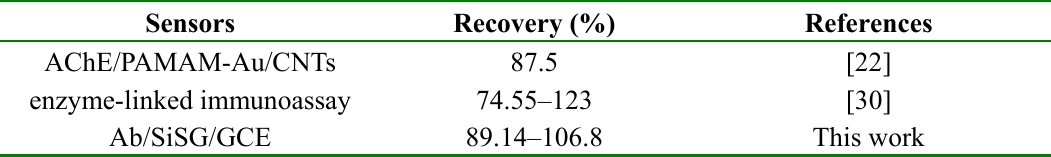
Table 1. The properties of this sensor compared with others